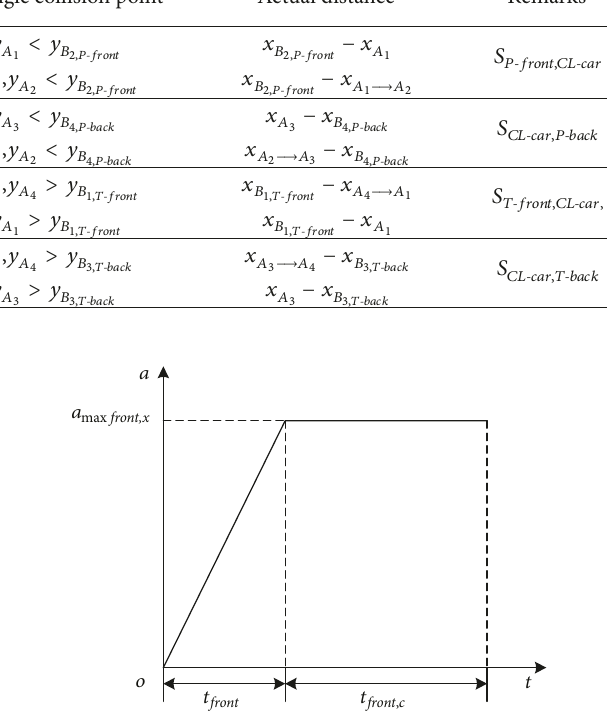
Figure 12: Braking deceleration changes of preceding vehicle.